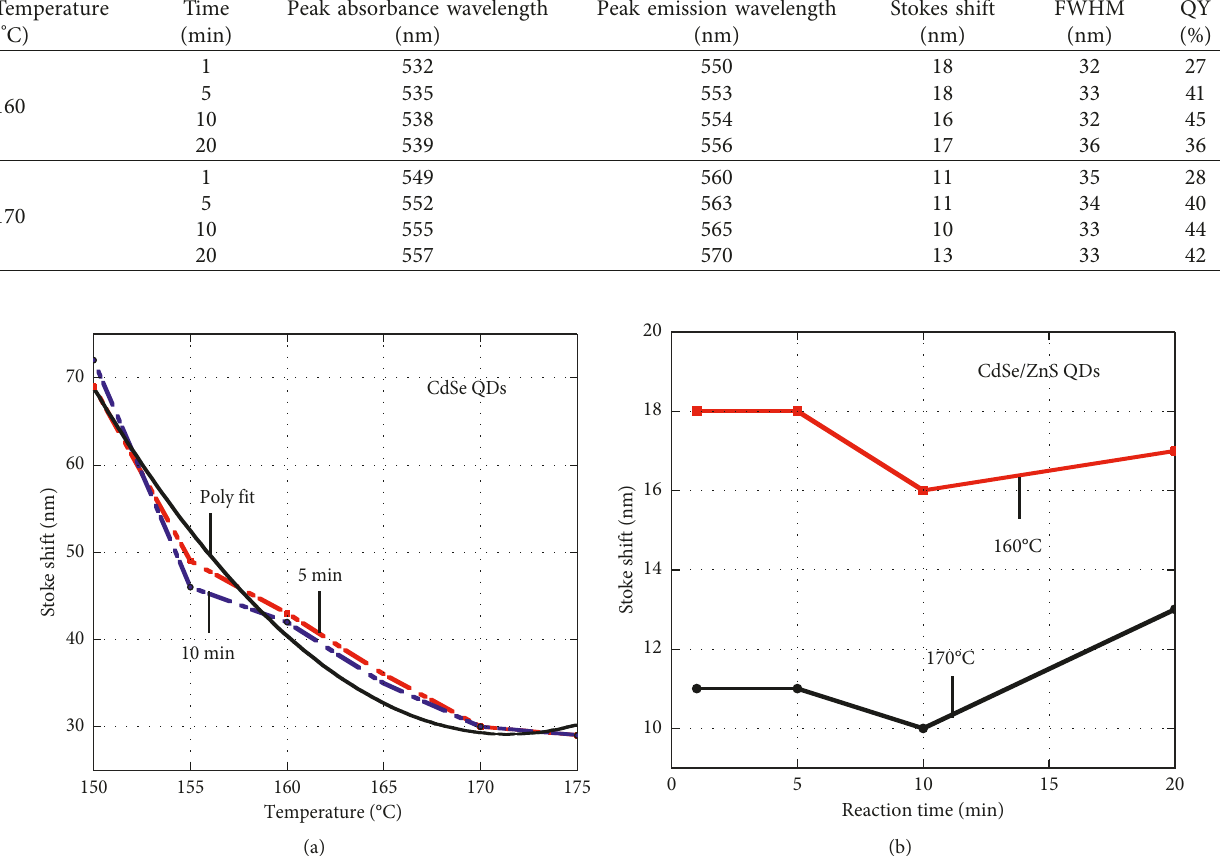
Figure 6: Stokes shift in bare CdSe core QDs (a) as a function of temperature and that in CdSe/ZnS core/shell QDs (b) as a function of reaction time,